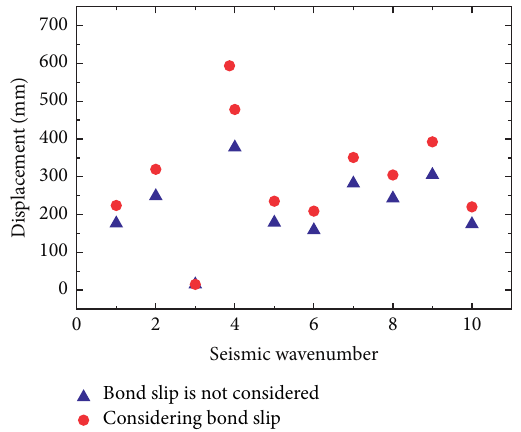
Figure 6: Longitudinal peak displacement of 10 waves.